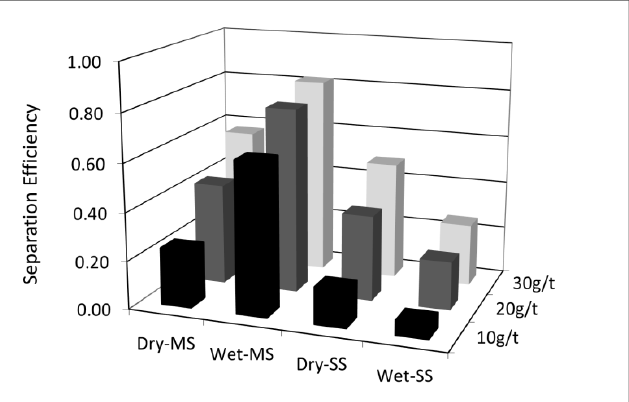
Figure 10. Separation efficiencies in flotation after different milling conditions.